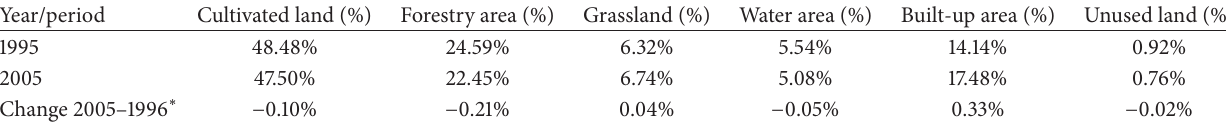
Table 3: Land use changes in Beijing-Tianjin-Tangshan Metropolitan area, 1995–2005.